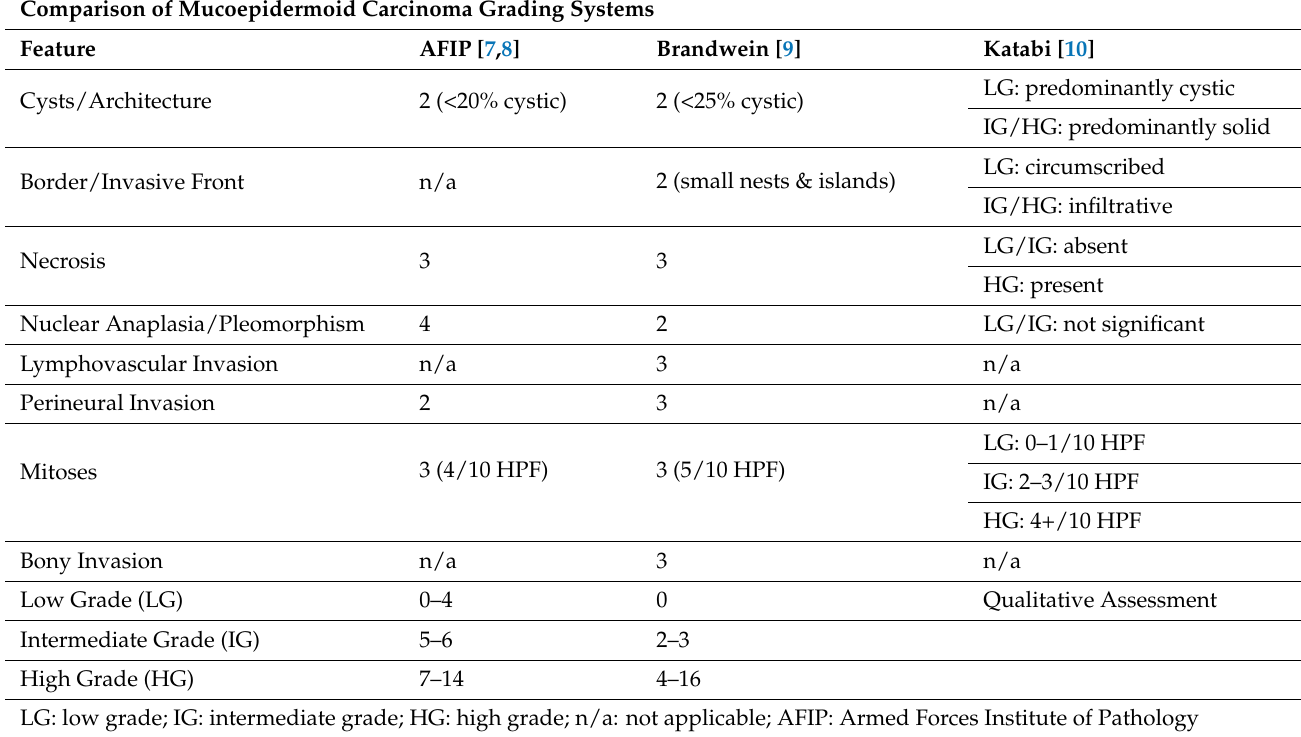
Table 3. Comparison of the mucoepidermoid carcinoma grading systems.